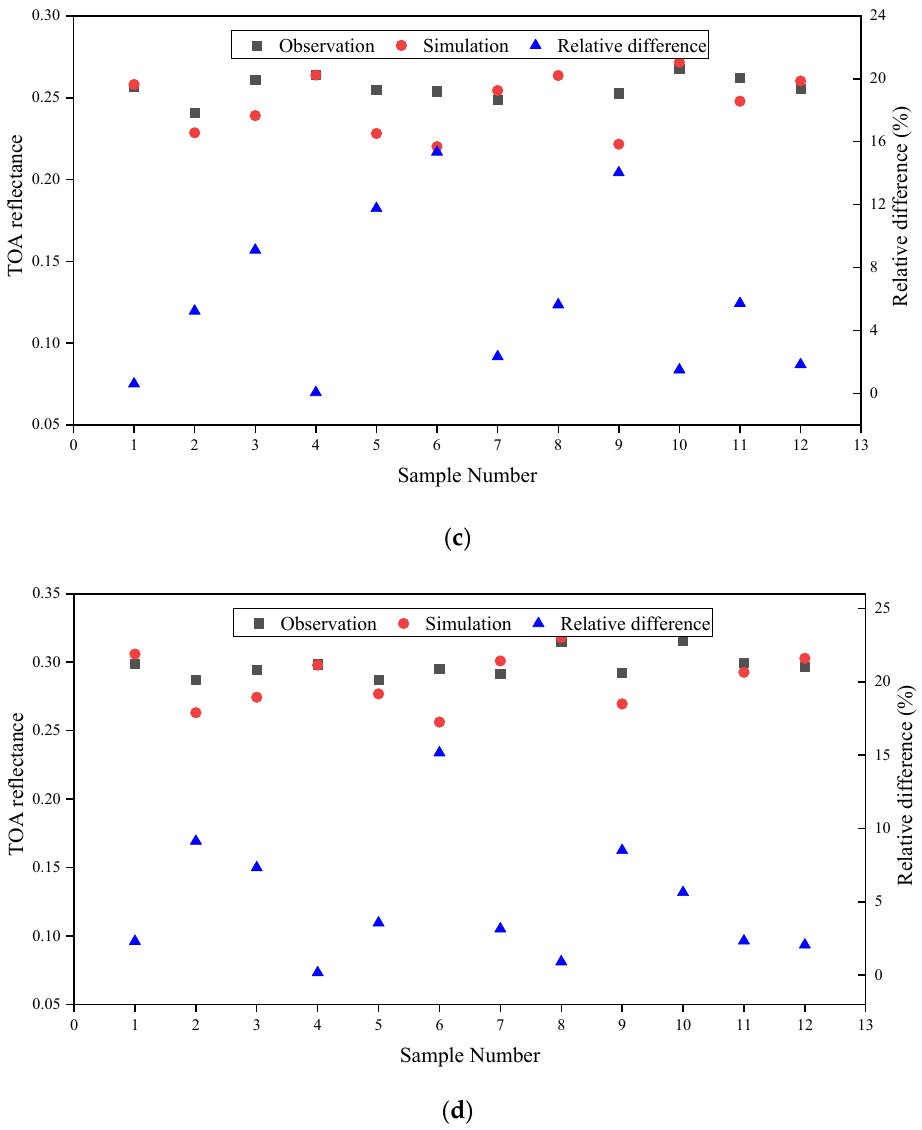
Figure 8. The compared results for the 12 calibration samples. ( a ) Band 2; ( b ) band 3; ( c ) band 4; ( d ) band 8.